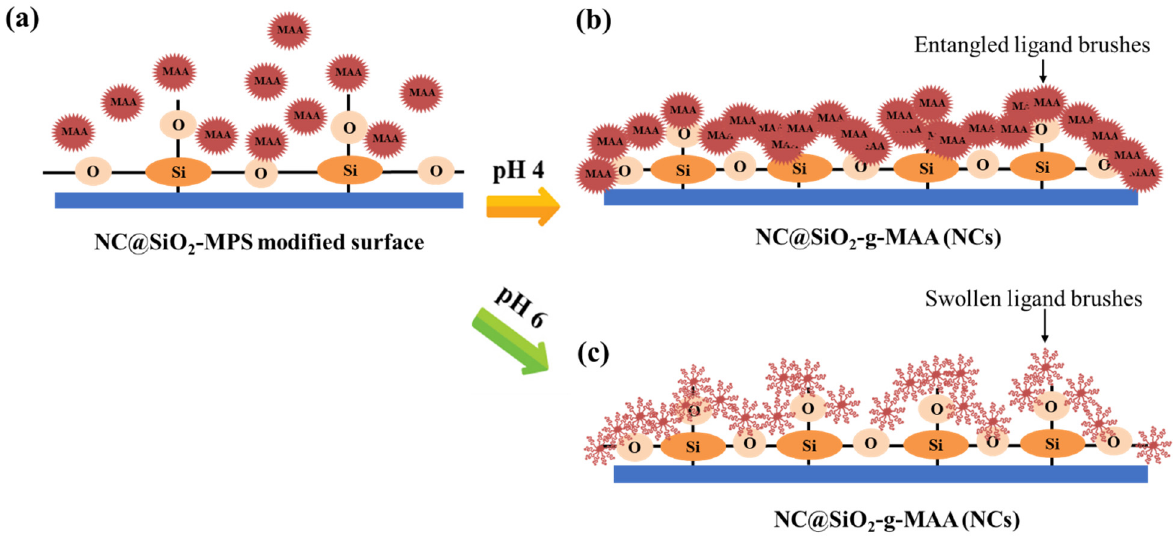
Figure 6. Self-controlled antibacterial drug release mechanism of the on the pristine NCs; ( a ) prepara- tion of ligand brushes on the NC surface, ( b ) pH trigger mechanism of the ligand brushes at pH 4, and ( c ) pH trigger mechanism at pH 6.